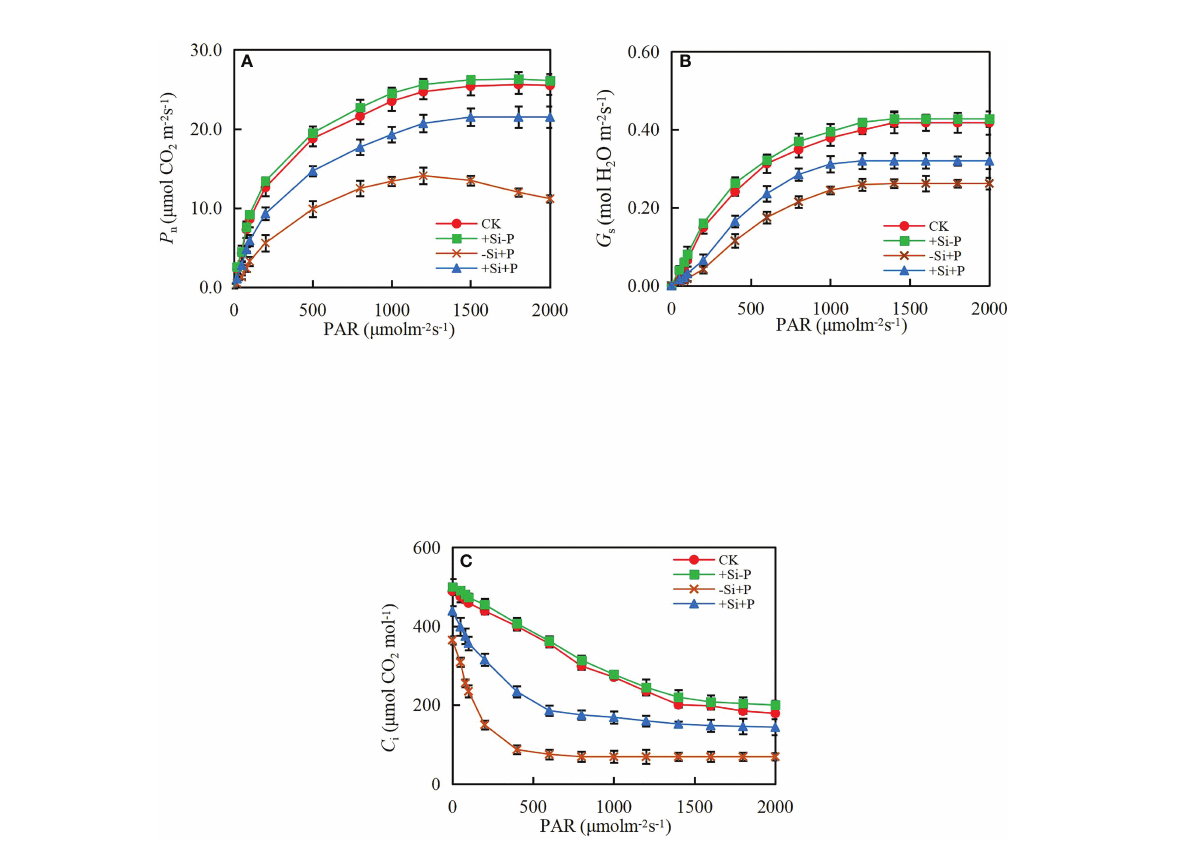
FIGURE 3 Response of (A) net photosynthetic rate ( P n ), (B) stomatal conductance ( G s ) and (C) intercellular CO 2 concentration ( C i ) to photosynthetic photon fl ux density (PAR) of oat leaves. CK, no Si application and no Pga inoculation; +Si-P, 1.5 mmol·L – 1 Si application and no Pga inoculation; -Si+P, no Si application and Pga inoculation; +Si+P, 1.5 mmol·L – 1 Si application and Pga